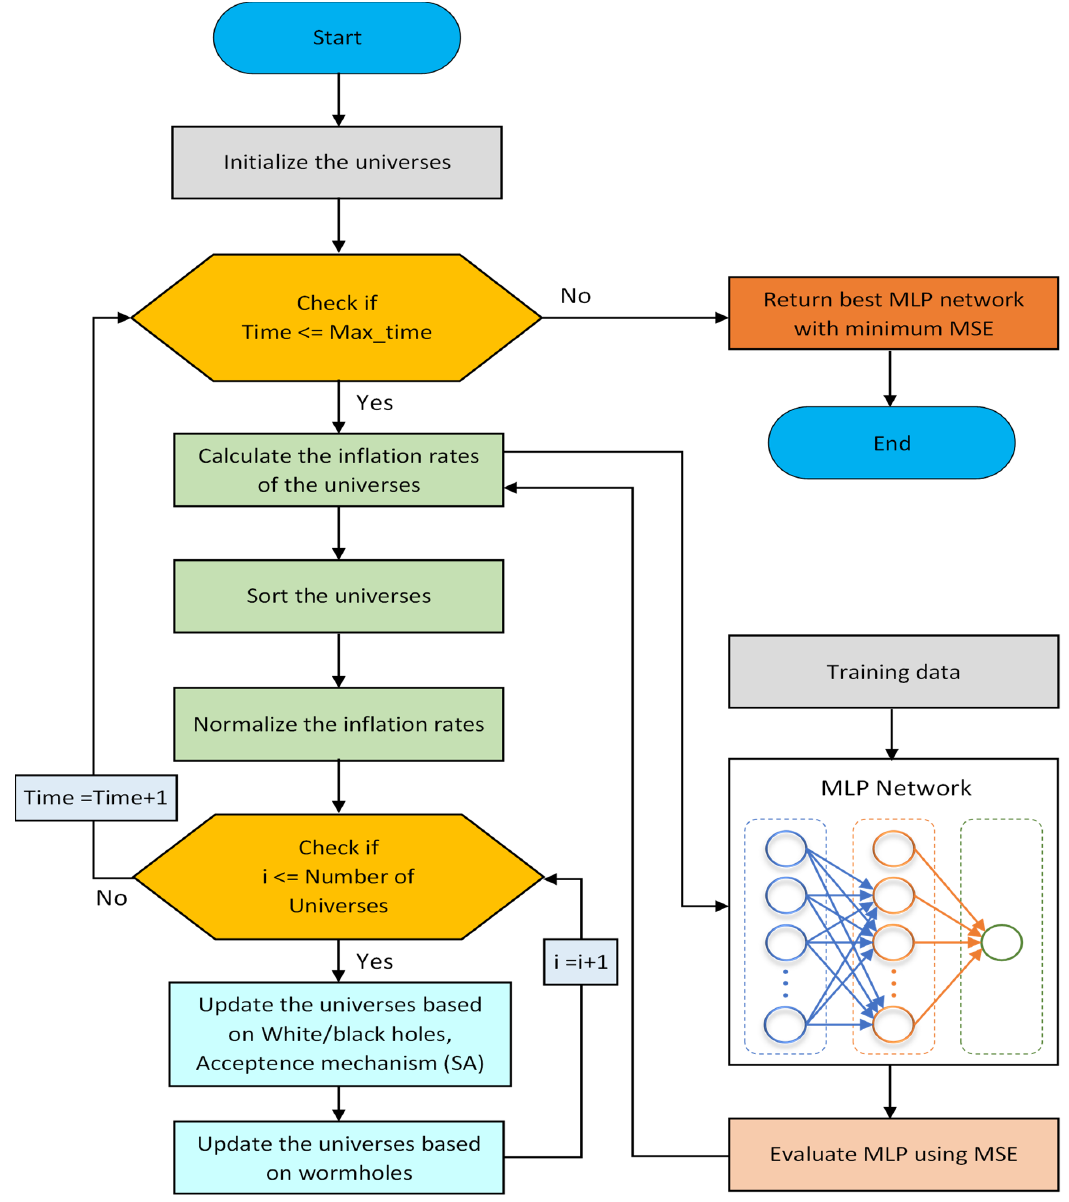
Fig. 5. General steps of the MVOSANN for the MLP network